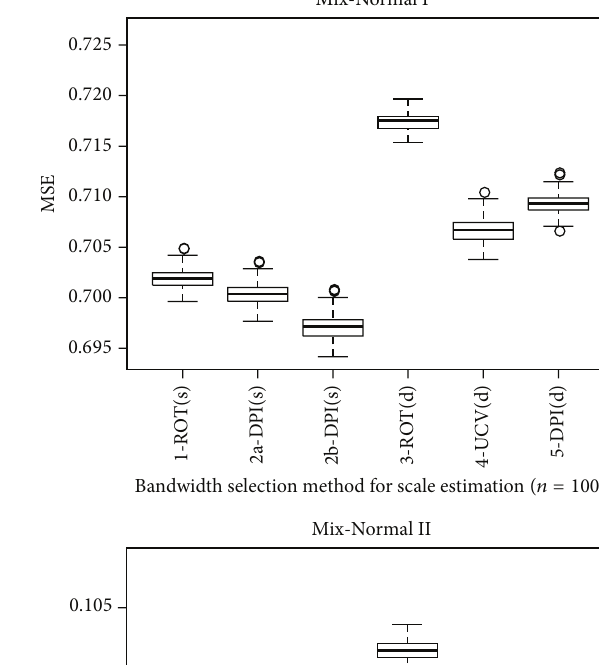
̂𝑈 Figure 6: The MSE of 1 in terms of bandwidth selection ̂ℎ ̂𝑔 ; “2b-DPI(s)” means with pilot bandwidth ̂𝑔 ROT ; density DPI ;𝑈 1 ̂ℎ DPI(d)” means DPI ; density